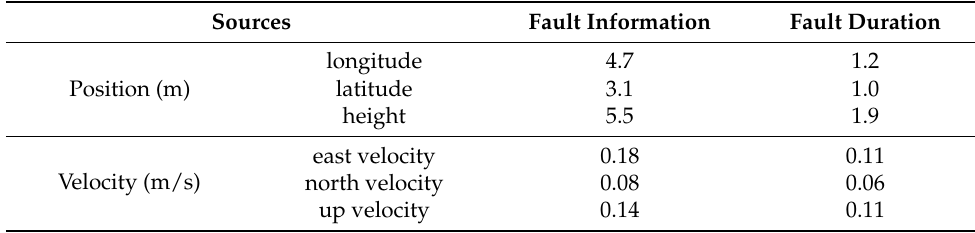
Figure 10. The box diagram of fused position errors under the single-satellite ramp fault. Table 5. RMS of navigation errors obtained by simulation under the single-satellite ramp